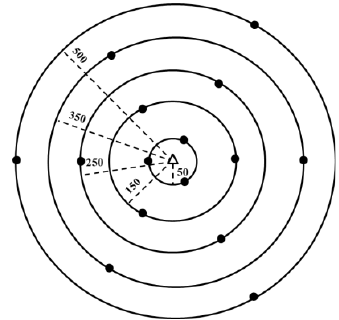
Figure 2. Experimental design for mapping the electromagnetic field around the cellular station. ( • ) Assigned points for measuring the power density. ( ∆ ) The cellular station. Numbers are distance in